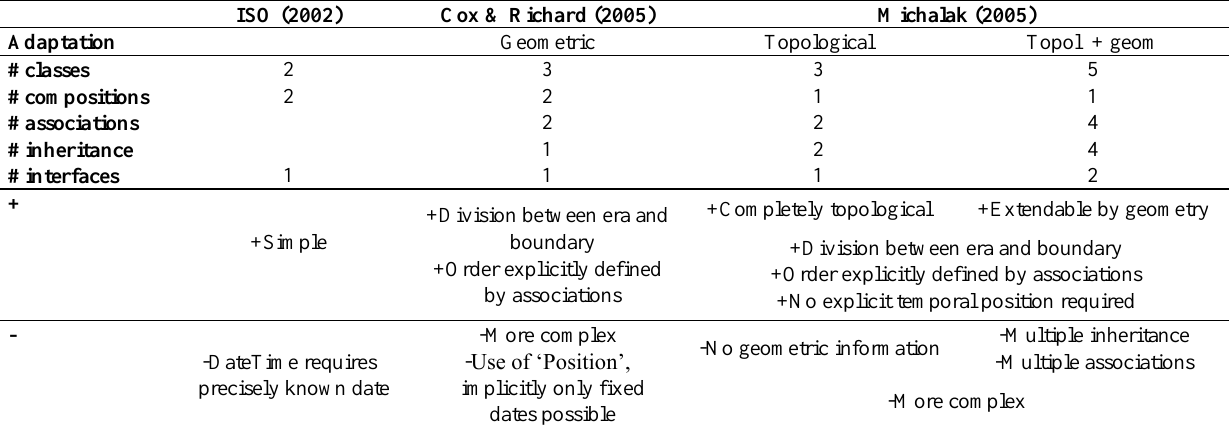
Table 5 Pros and cons for the application of the ISO 19108 model for temporal ordinal reference systems, the variants of Cox and Richard (2005) and Michalak (2005) to the archaeological time